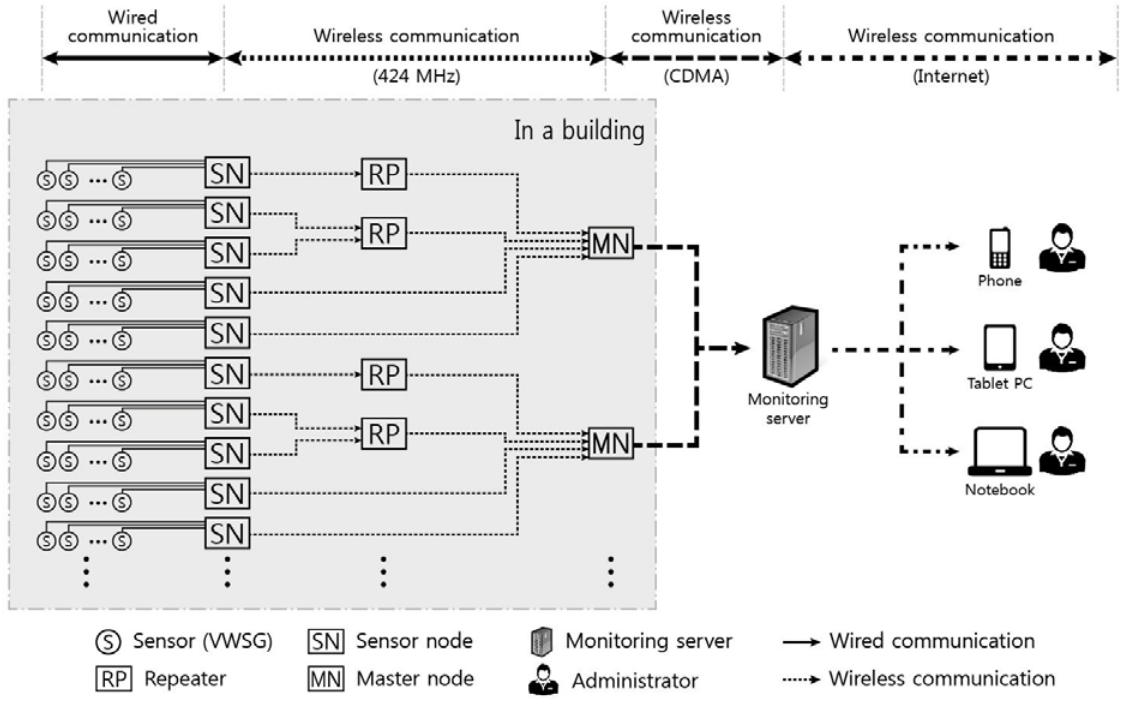
Figure 2. Wireless sensor network system for measurement of column shortenings in a high-rise